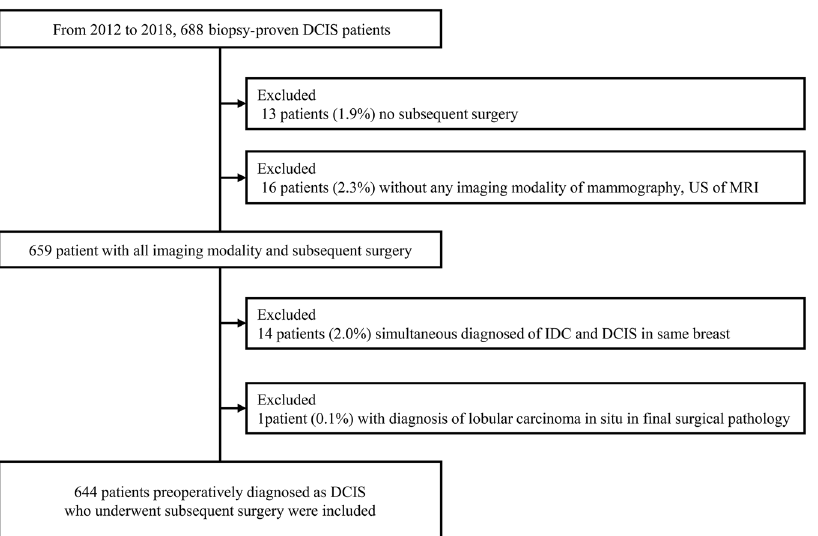
Fig. 1 Flow chart of the study population. After we reviewed the biopsy database for biopsy-con fi rmed DCIS at our institution, we identi fi ed 688 biopsy-proven DCIS. This fl owchart brie fl y presents how many patients were excldued and the reasons of